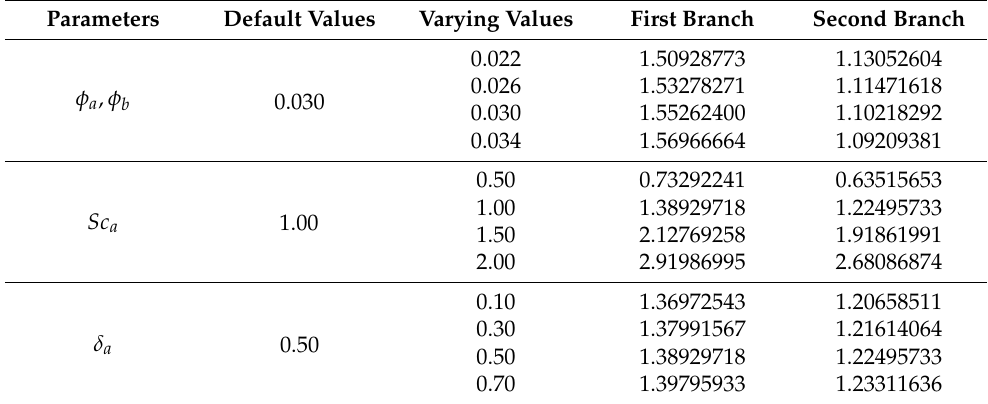
Table 5. Numerical values of the quantity Sh x for both the FBS and SBS